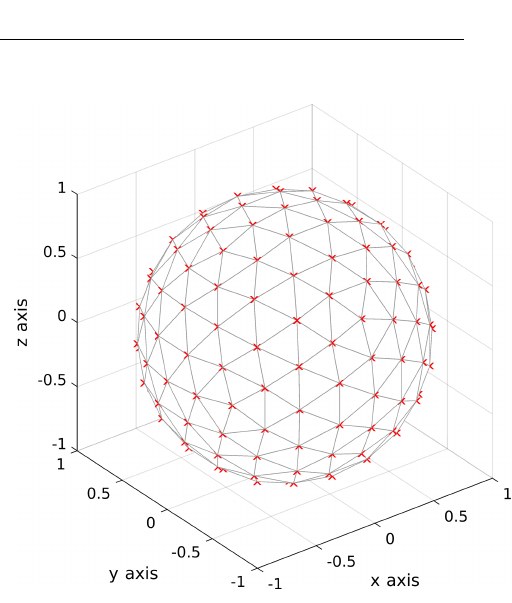
Figure 6. Example of an icosphere grid with 162 vertices. Each grid point represents an incoming angle for which a DDA calculation is performed. This type of configuration ensures that the grid density is isotropic, making the overall calculations more efficient (a standard polar grid would be inefficient, since it yields an excessive amount of angles around the “north and south